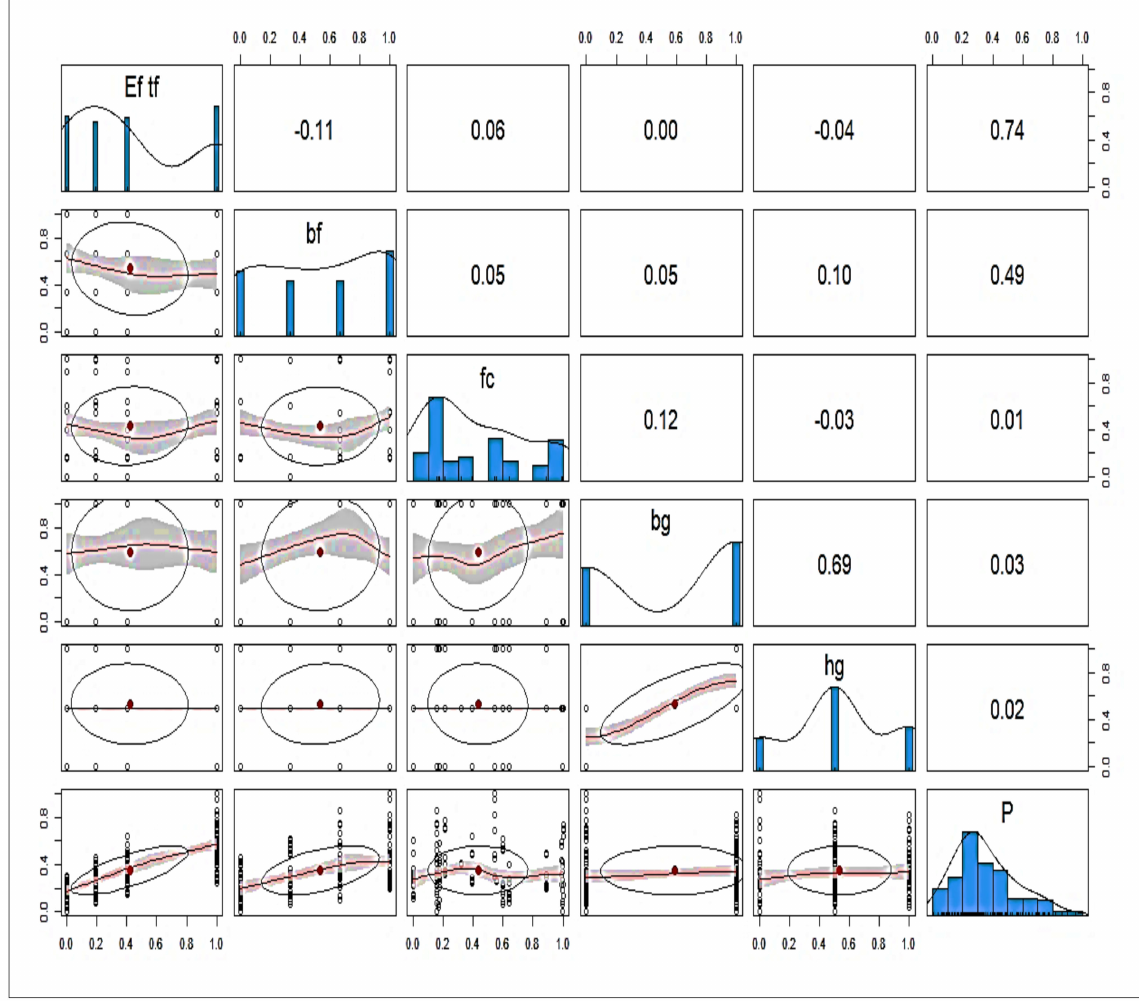
Figure 3. Pearson correlation with heat